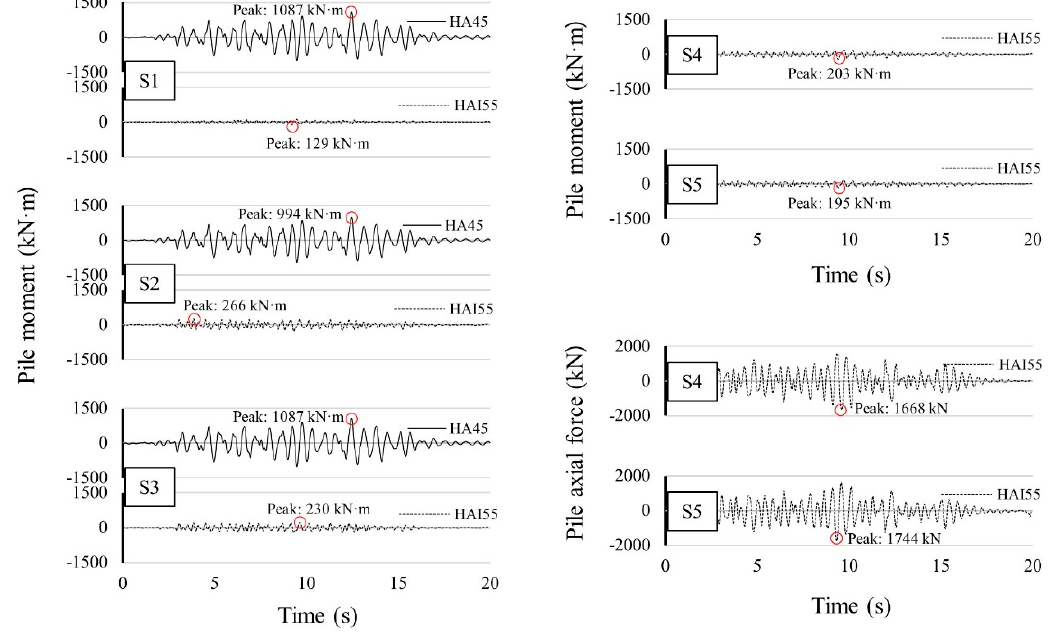
Figure 8. Pile moment and axial force time histories of horizontal ground model (0.15 g) (scaled to the prototype).